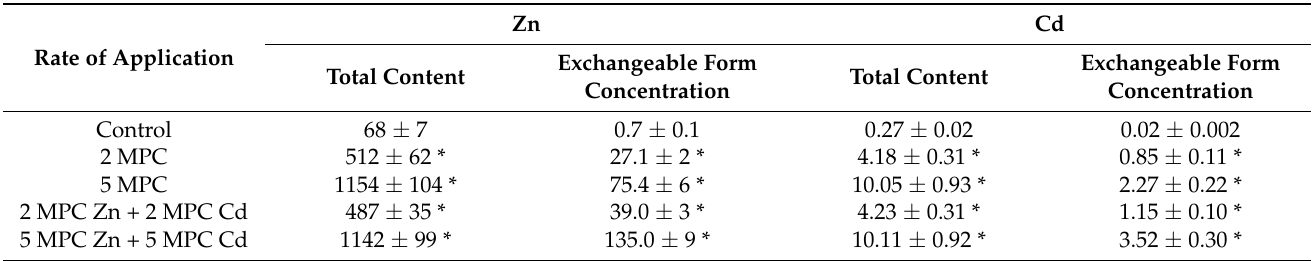
Table 1. Zinc and Cd total content and exchangeable form concentrations in soil exposed to spiking individual or combined metals,